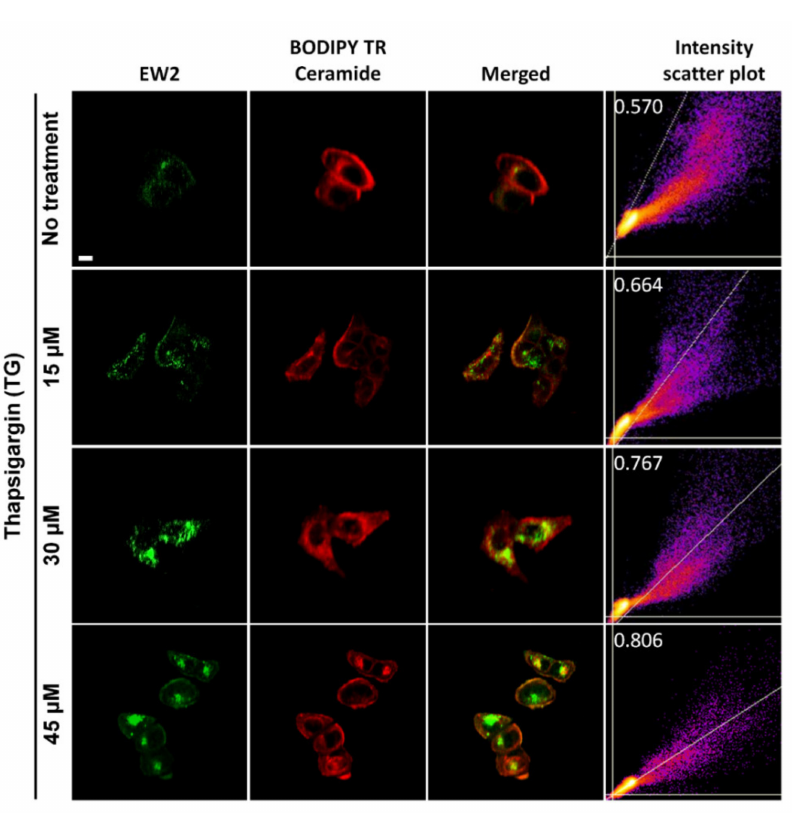
Figure 5. Images of MCF7 cells co-incubated with BODIPY TR Ceramide tracker dye and EW2 (5 µ M) after TG treatment (0–45 µ M). Fluorescence images of the green and red channels, and merged images. The intensity scatter plot was obtained by quantifying the green and red channel images at different concentrations. Scale bar = 10 µ m. The green channel: λ ex = 470 nm, λ em = 500–550 nm; red channel: λ ex = 561 nm, λ em = 570–620